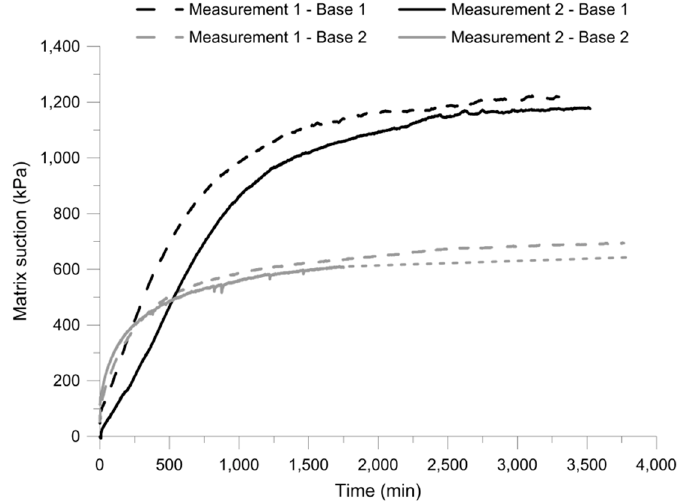
Figure 8. High-capacity tensiometer measurements conducted on Specimen 3 at the end of the last drying stage (the dotted segment is an extrapolation of the last measurement).